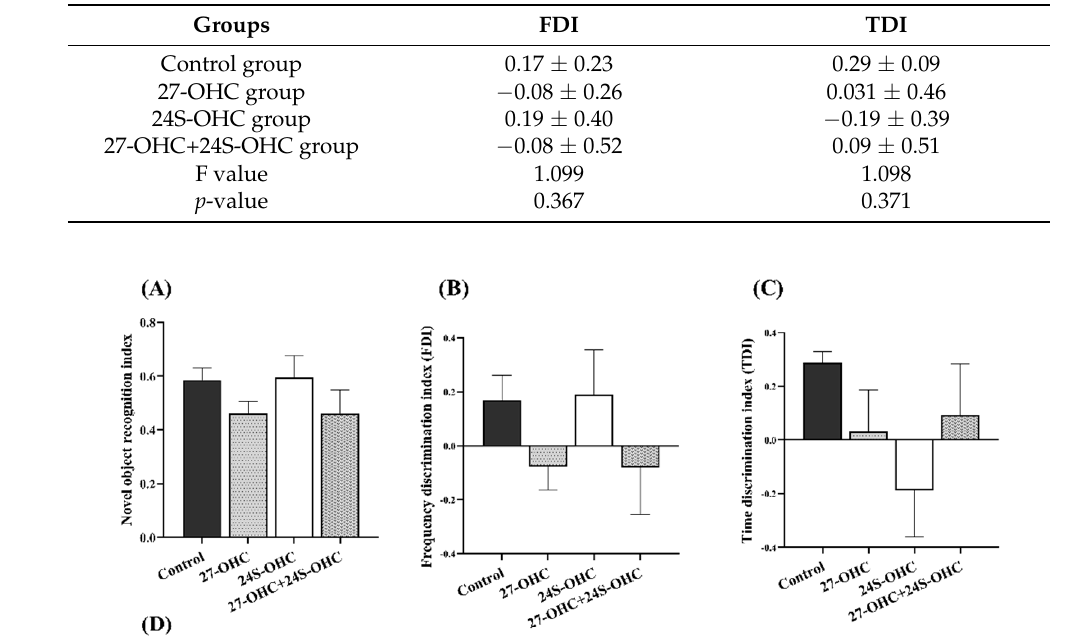
Table 1. FDI and TDI values in novel object recognition test ( n = 10).